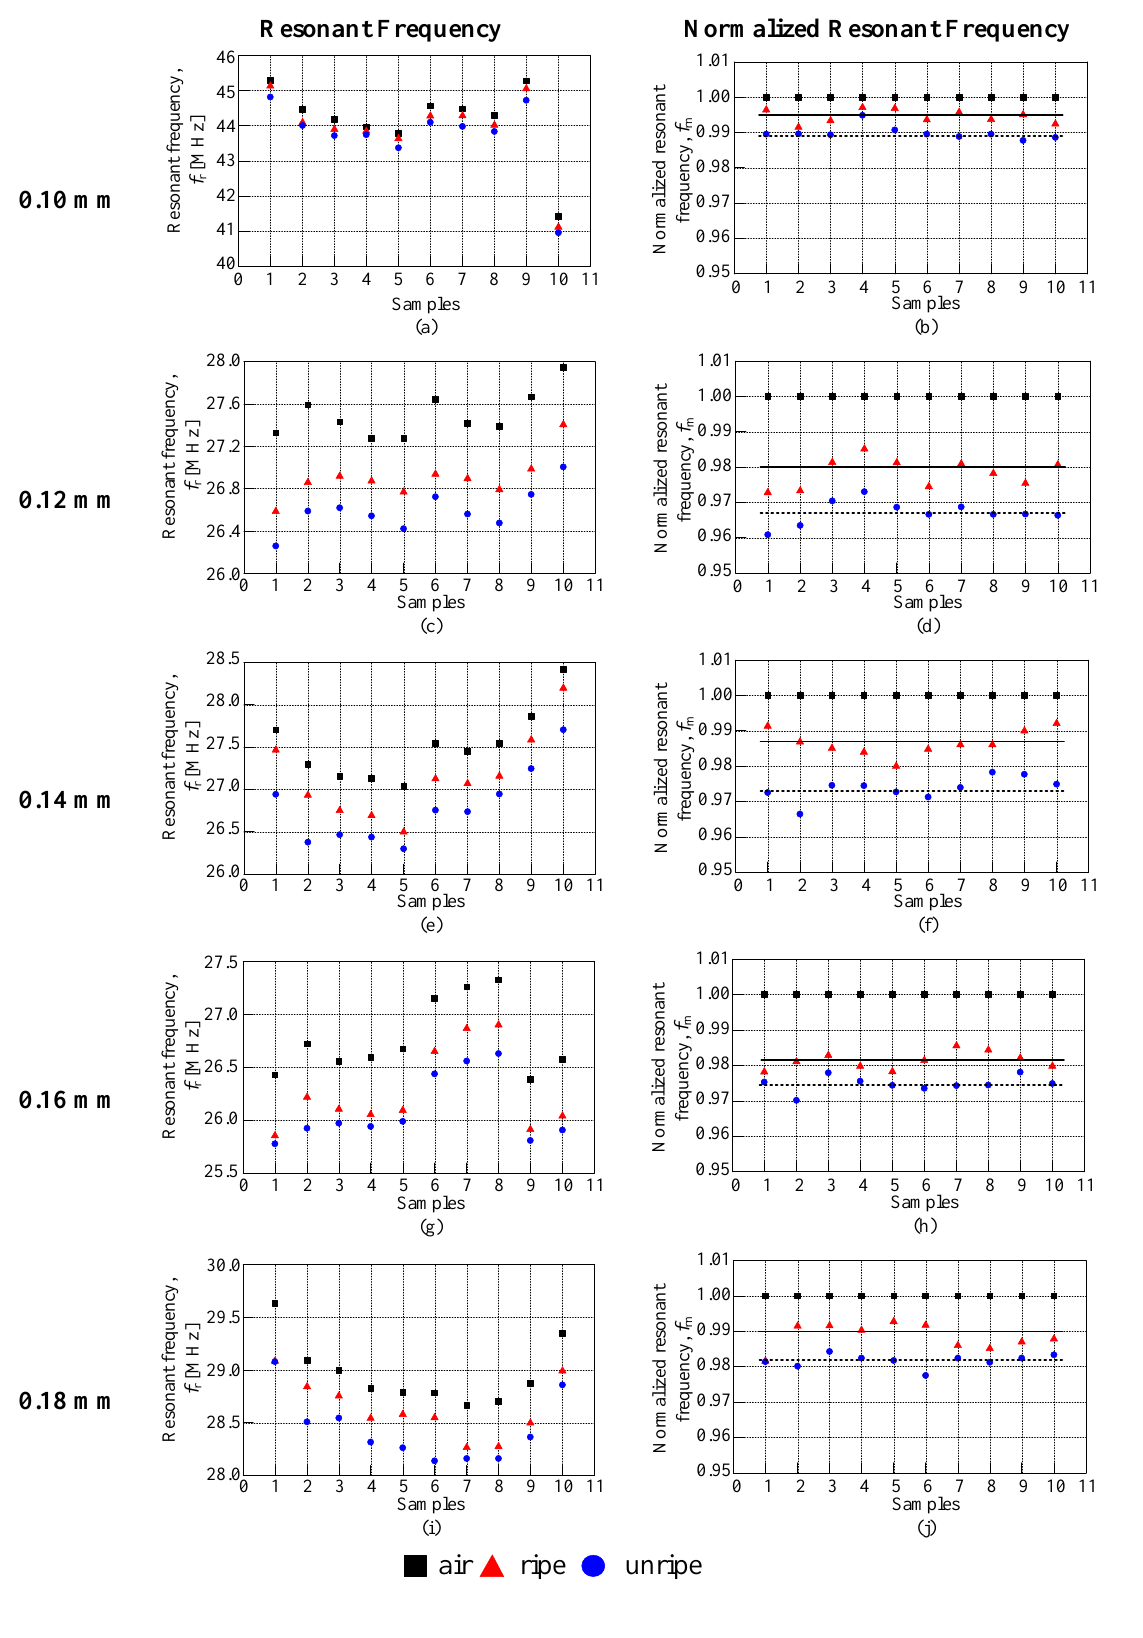
Figure 7. The normalized resonant frequency for 5 mm air coil length. Resonant Frequency Normalized Resonant